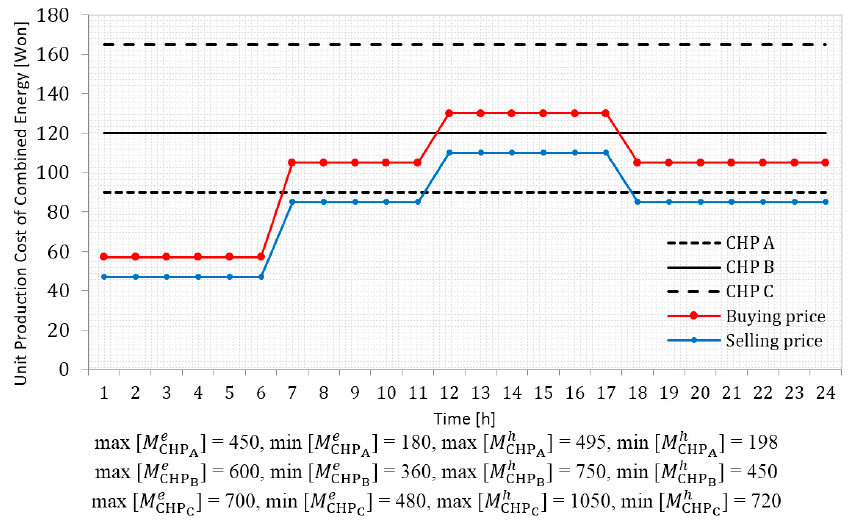
Figure 3. Unit production cost of combined E and H energy of CHPs. Table 1. Combined electric and heat ( E and H ) energy production cost of CHPs. Table 2. External trading prices by time of use (TOU) plan.